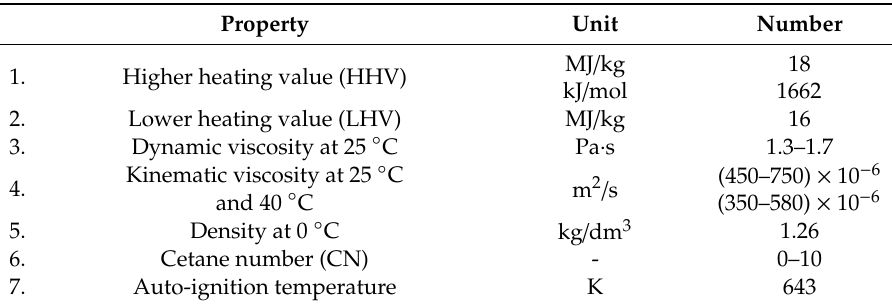
Table 1. Glycerol main physical properties [6–9].